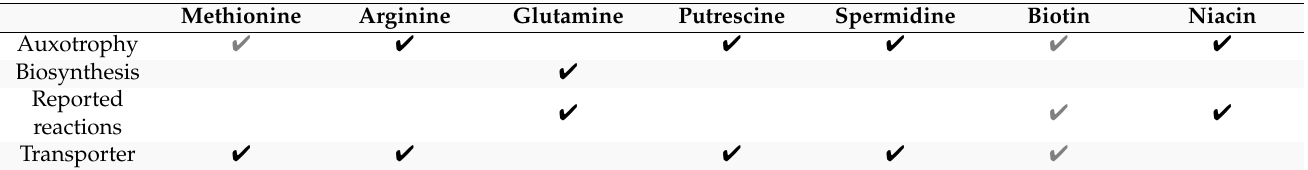
Table 1. Overview of reported auxotrophies and biosynthetic pathways. Brugger et al. investigated auxotrophies and biosynthetic pathways based on functional genomic predictions [25]. Reported auxotrophies and biosynthesis were verified using i DPM21RW and in silico predictions. Additionally, reported reactions and transporters were checked for their presence. A black check-mark ( (cid:52) ) indicates a correct prediction or occurrence of the model’s instance; a check-mark in gray ( (cid:52) ) indicates a correct prediction or occurrence after model modifications; and a black cross ( (cid:56) ) indicates a discrepancy between the functional genomic predictions and the model. However, we could not find any discrepancy for auxotrophies and biosynthetic